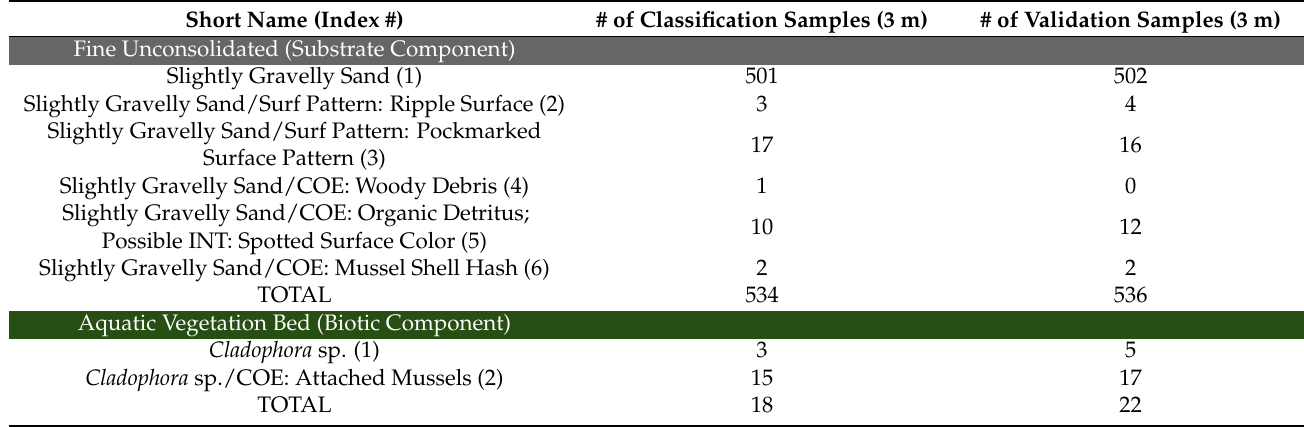
Table 3. Number of ground truth points (samples) for classification and validation used for Tier 2 classification of the 3 m airborne data (# = number).